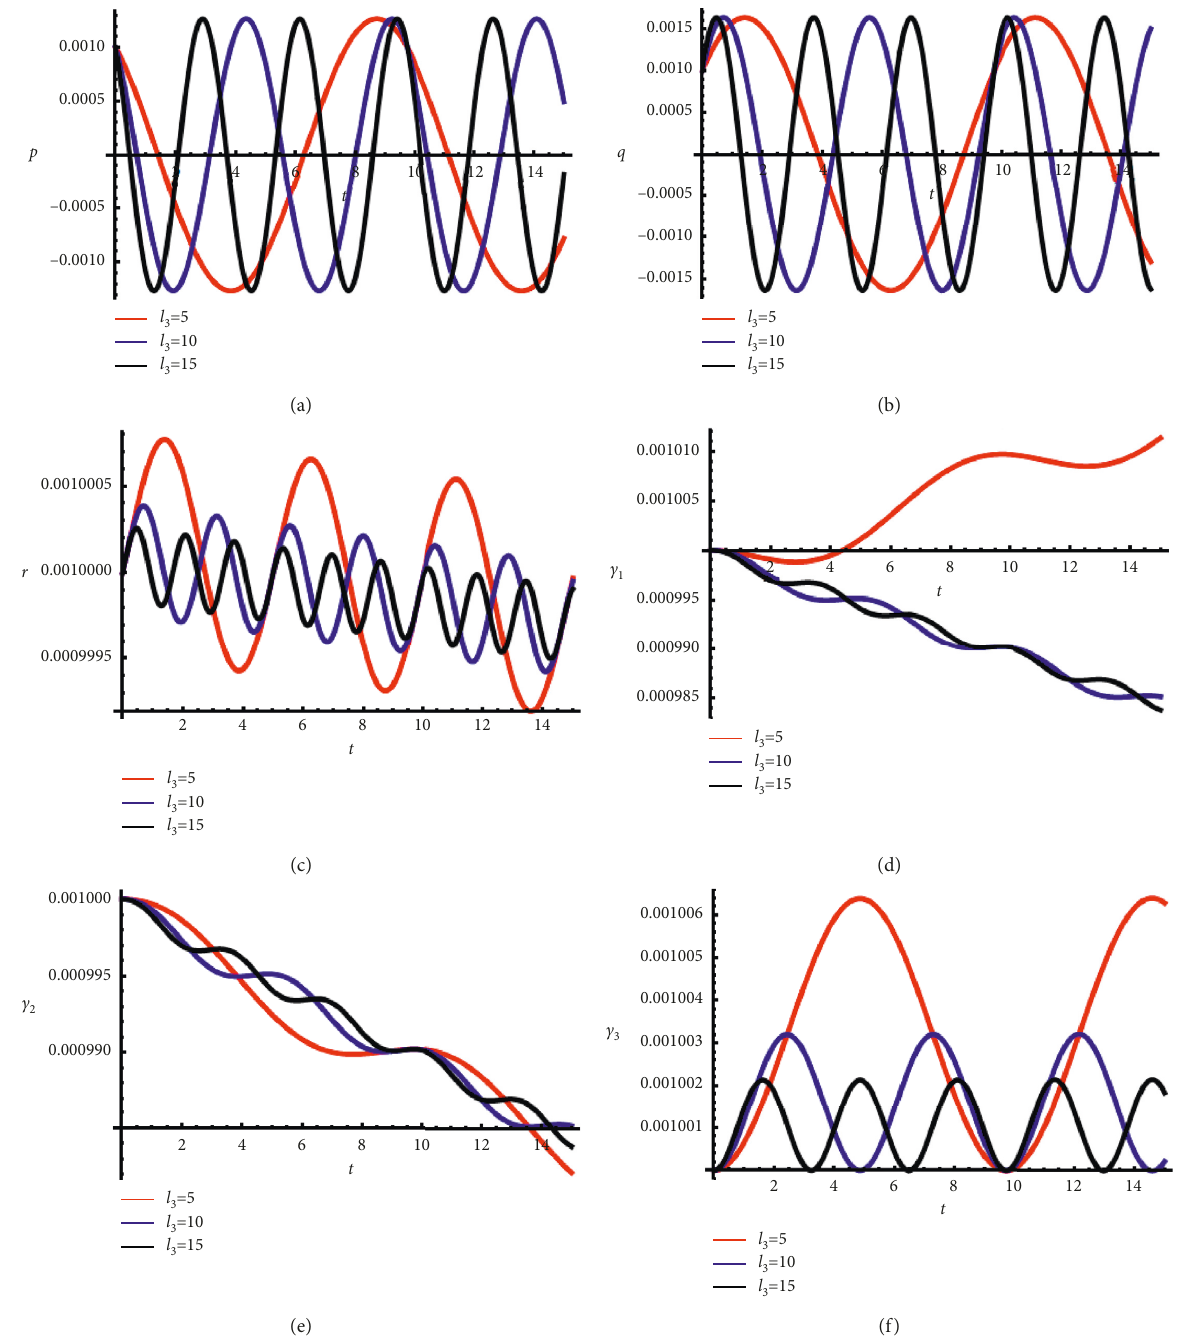
Figure 6: Time histories of the numerical solutions of p,q,r, c 5 , 10 , 15 ) kg.m 2 .s − 1